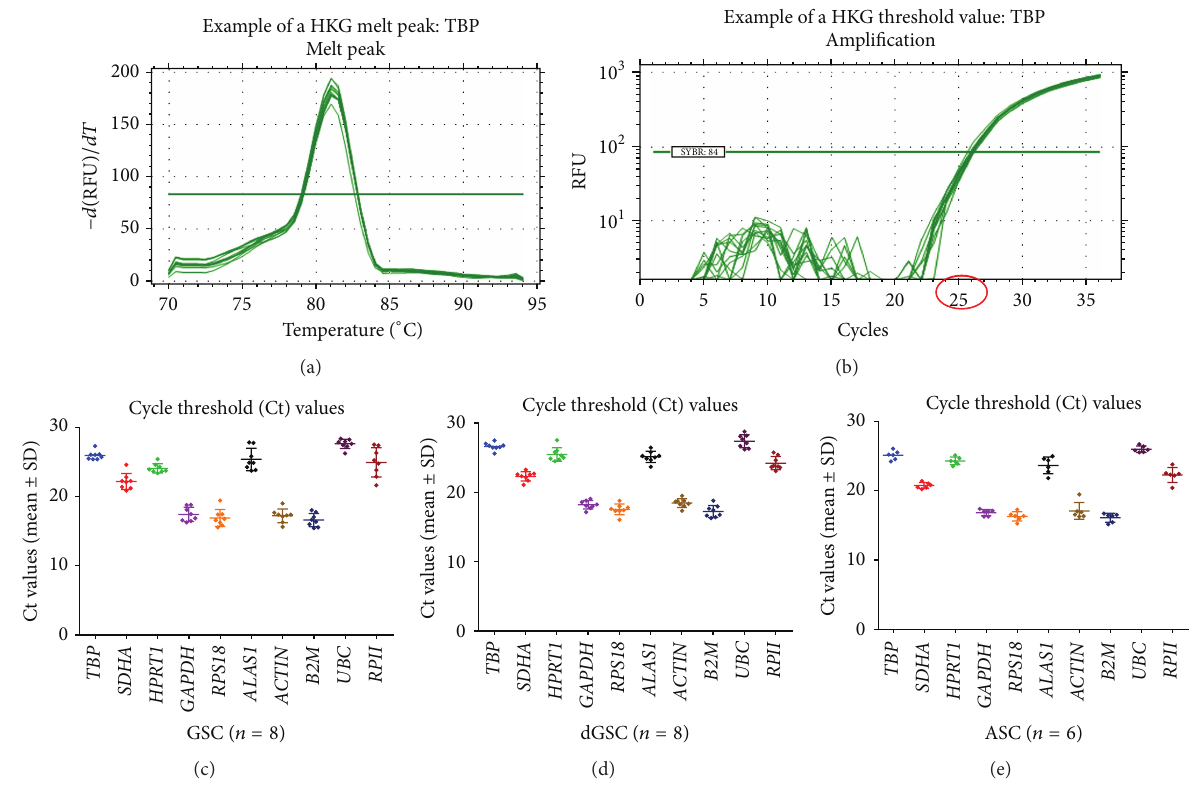
Figure 2: PCR reaction values and expression levels of the 10 candidate reference genes. (a) Melt peak temperature was determined for each reference gene to confirm the specificity of each primer. (b) Threshold values were manually set for each reference gene to calculate cycle threshold (Ct) values. (c), (d), and (e) Expression levels ( Ct values ) were determined for all reference genes throughout all the samples: (c) GSCs ( 𝑛 = 8 ), (d) dGSCs ( 𝑛 = 8 ), and (e) ASCs ( 𝑛 = 6 ). The central bars correspond to the mean Ct values; the upper and lower bars represent the standard deviation. These values were used in Δ Ct and BestKeeper